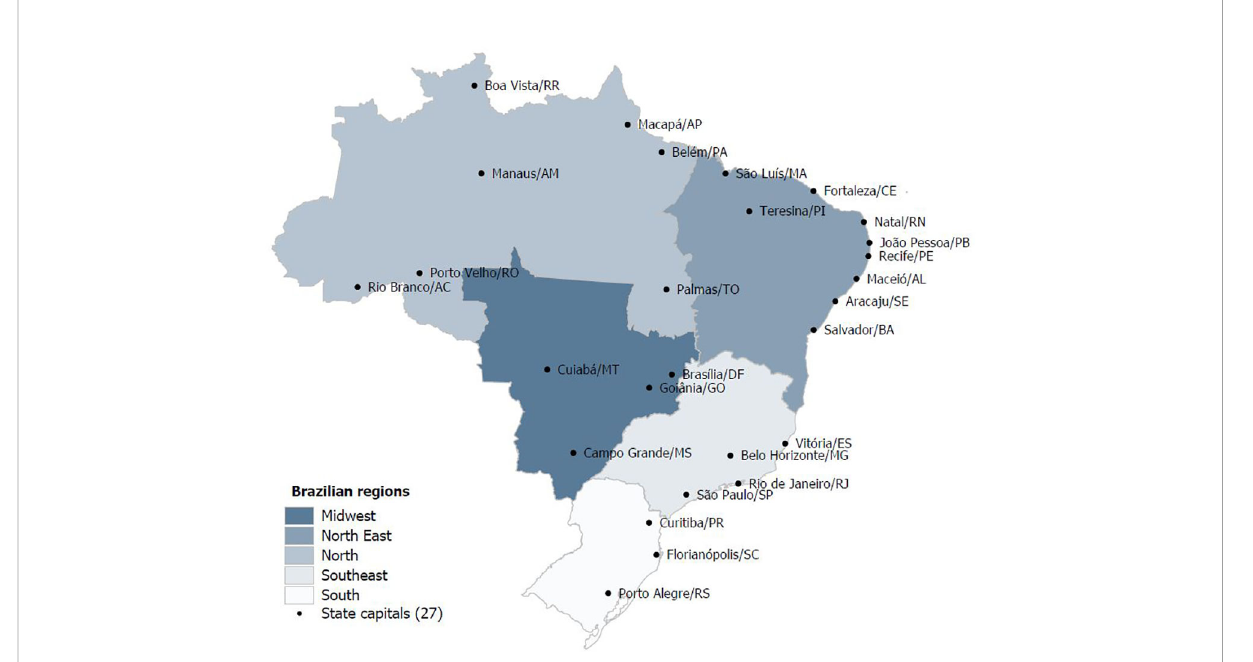
FIGURE 1 Brazilian geographical